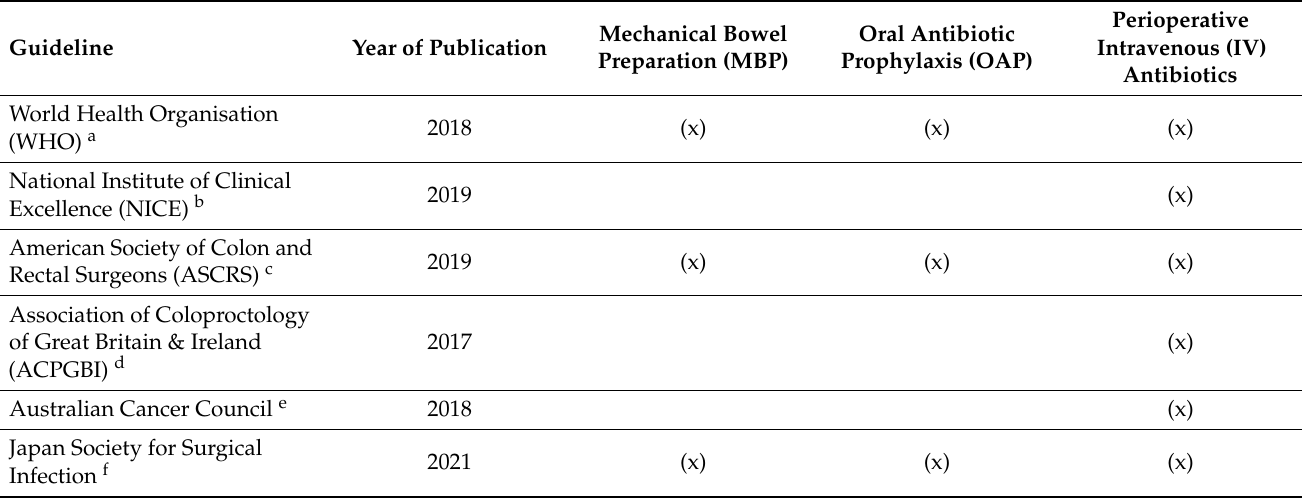
Table 1. Current recommendations on the use of MBP and OAP in elective colorectal